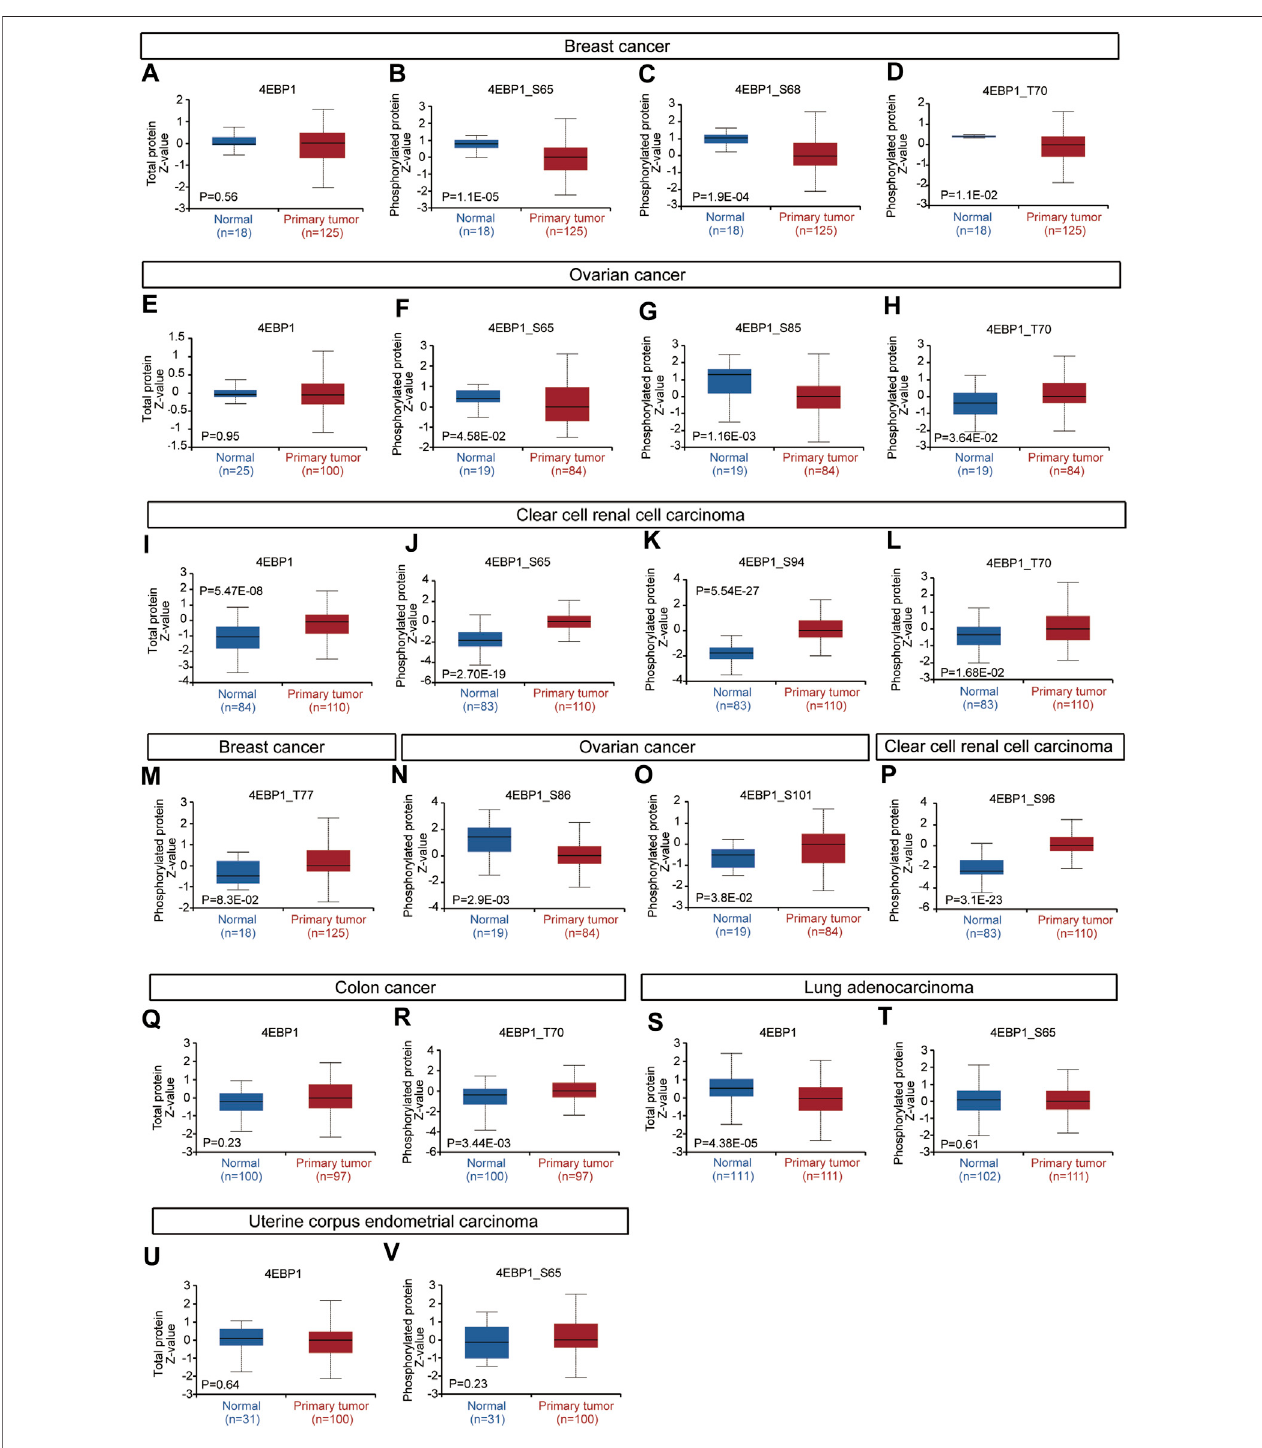
FIGURE3| Expressionlevelof4EBP1proteinandp-4EBP1phosphoproteinsindiversetumors.BasedontheCPTACdataset,weanalyzedtheexpressionlevelof 4EBP1 total protein and phosphoproteins (S65, S68, T70, T77, S85, S86, S94, S96, and S101 sites) between normal tissue and primary tissue of selected tumors. (A – D,M) Breast cancer. (E – H,N,O) Ovarian cancer. (I – L,P) Clear cell renal cell carcinoma. (Q,R) Colon cancer. (S,T) Lung adenocarcinoma. (U,V) Uterine corpus endometrial carcinoma.